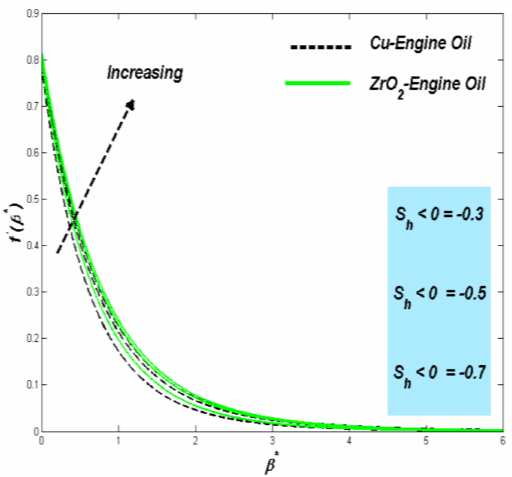
Figure 5. Velocity profile change with S h < 0.